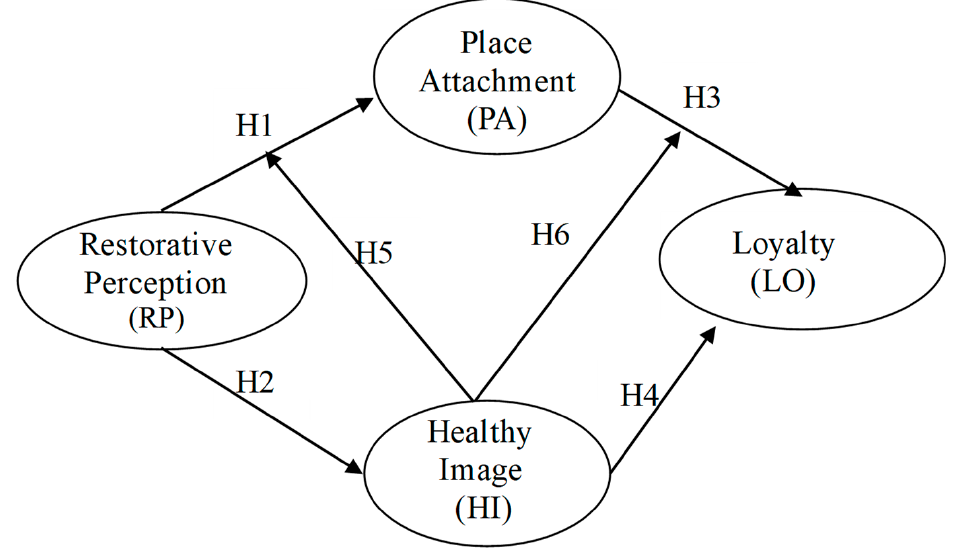
Figure 1. Research frame.